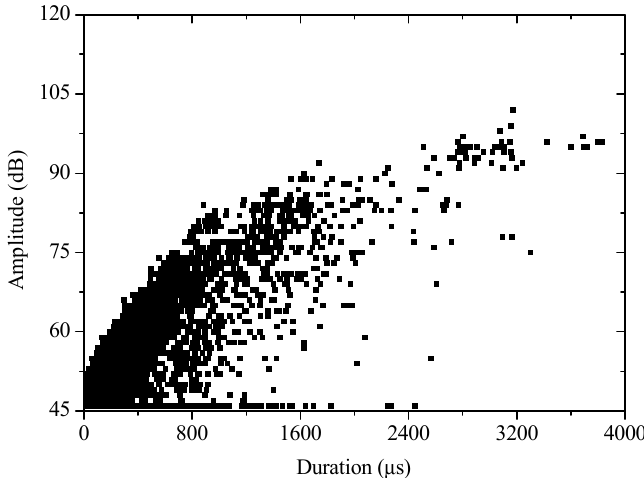
Figure 7. AE amplitude vs. duration (0.5 kg/m 3 ).